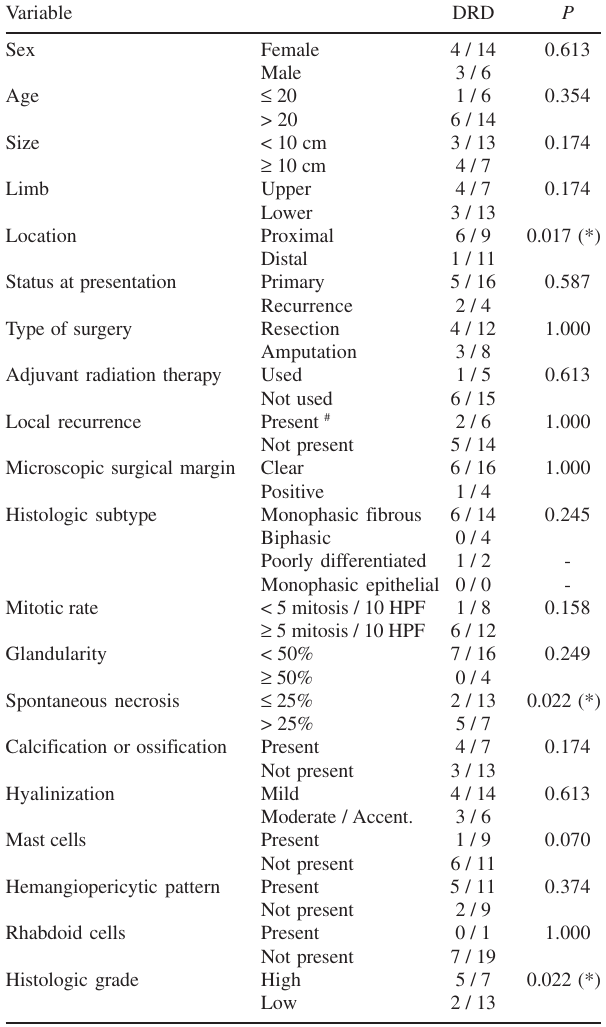
Table 4 - Disease-related survival according to all variables Variable